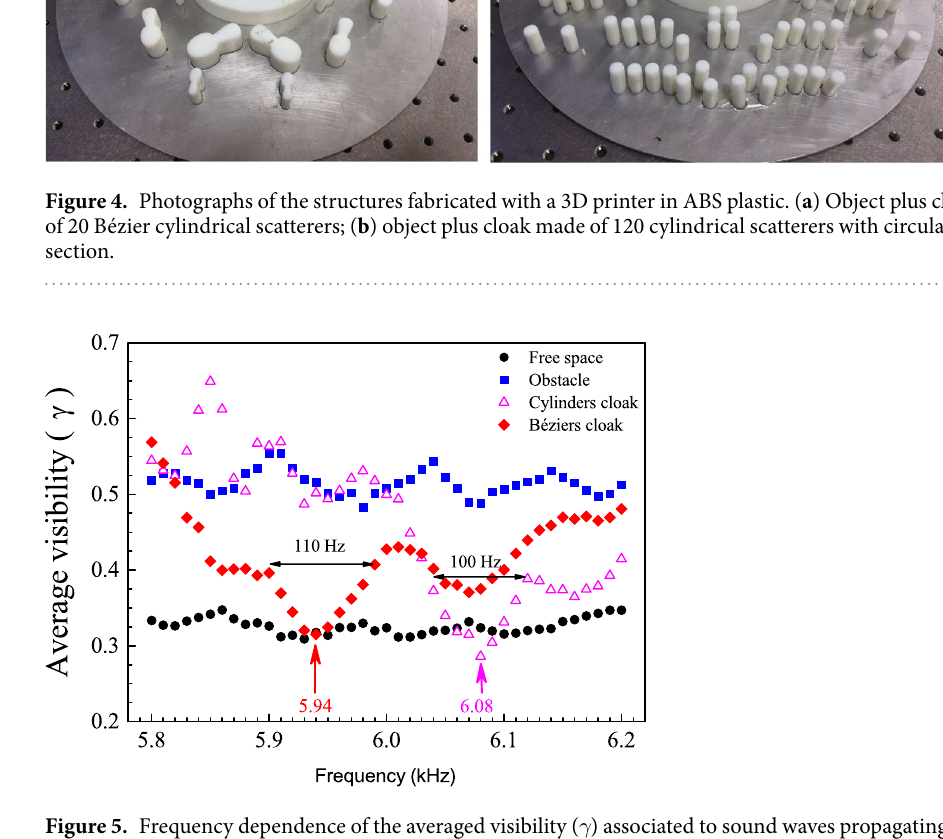
Figure 5. Frequency dependence of the averaged visibility ( γ ) associated to sound waves propagating in free space (black dots) and the waves interacting with a rigid circular obstacle placed at the center of the waveguide (square symbols). The diamond symbols (hollow triangles) represent the data measured when the obstacle is surrounded by the cloak made of 20 Bézier scatterers (120 circular cylinders). The acoustic cancellation occurs at 5.94 kHz and 6.08 kHz for the case of the Bézier cloak and cylinder cloak,